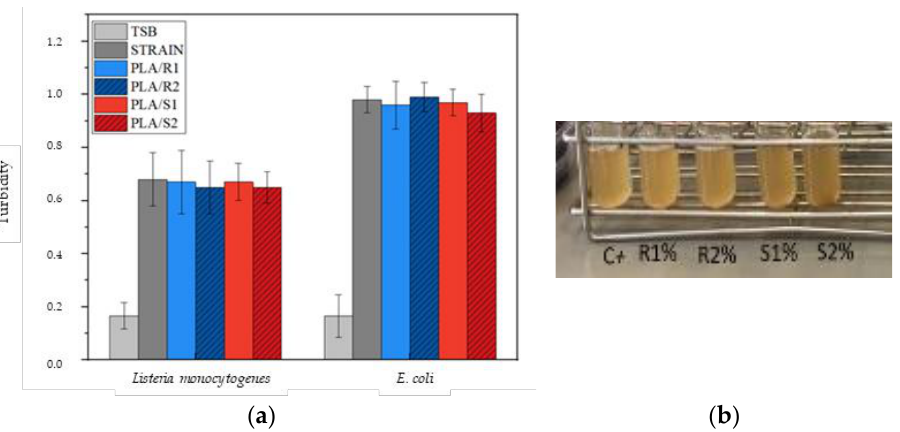
Figure 8. Bacterial activity of ( a ) compounds in compound form PLA/R1, PLA/R2, PLA/S1 and PLA/S2 microtiter plate assays for bacteria Listeria monocytogenes and E. coli ( b ) Tube turbidity. Standard deviation calculated with three replications per test.